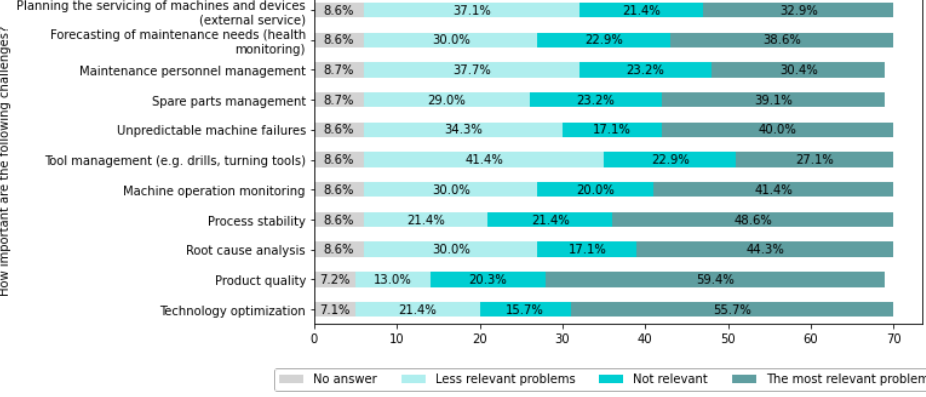
Figure 18. Challenges related to the manufacturing process — number of questionnaires in a total number of 70 questionnaires.